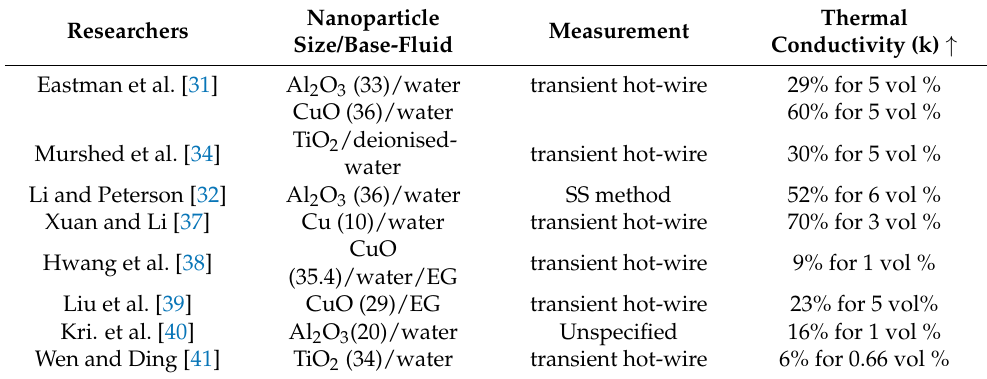
Table 1. An overview of various nanofluids and thermal conductivity.